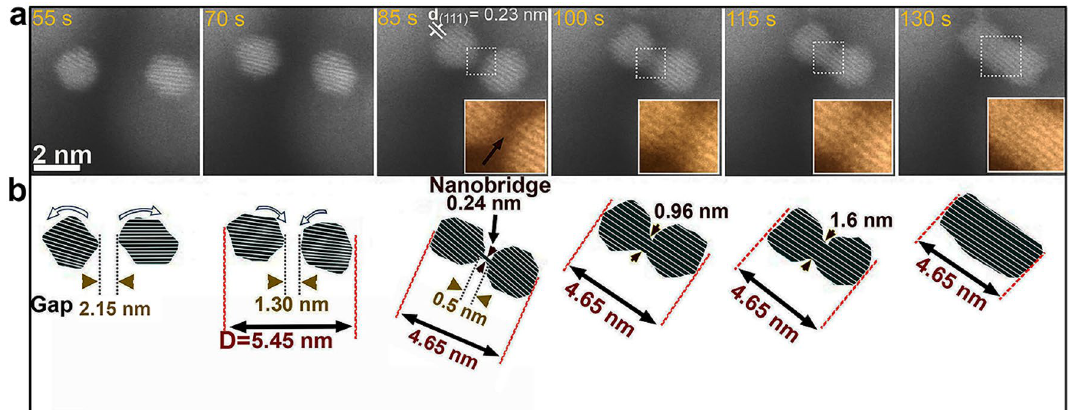
Figure 3. Oriented attachment via nanobridge-induced contact. ( a ) Atomic resolution ADF-STEM time- series showing the OA process of two small Pt nanocrystals, indicating the approach of nanocrystals and pre- alignment by rotation, followed by nanobridge formation (marked by the black arrow in the inset at 85 s) and subsequent fusion of the nanocrystals. ( b ) Schematic illustration of the nanobridge-induced OA process. Images in the insets are shown in false